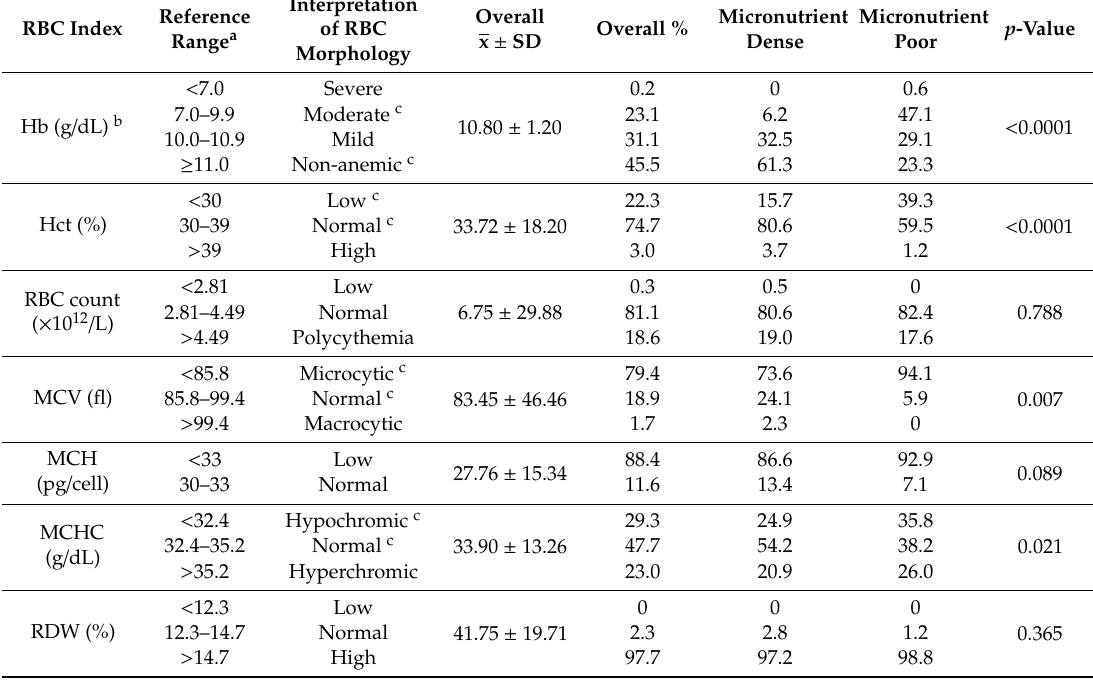
Table 3. Distribution of anemia by red blood cell morphology stratified according to adequacy of micronutrient